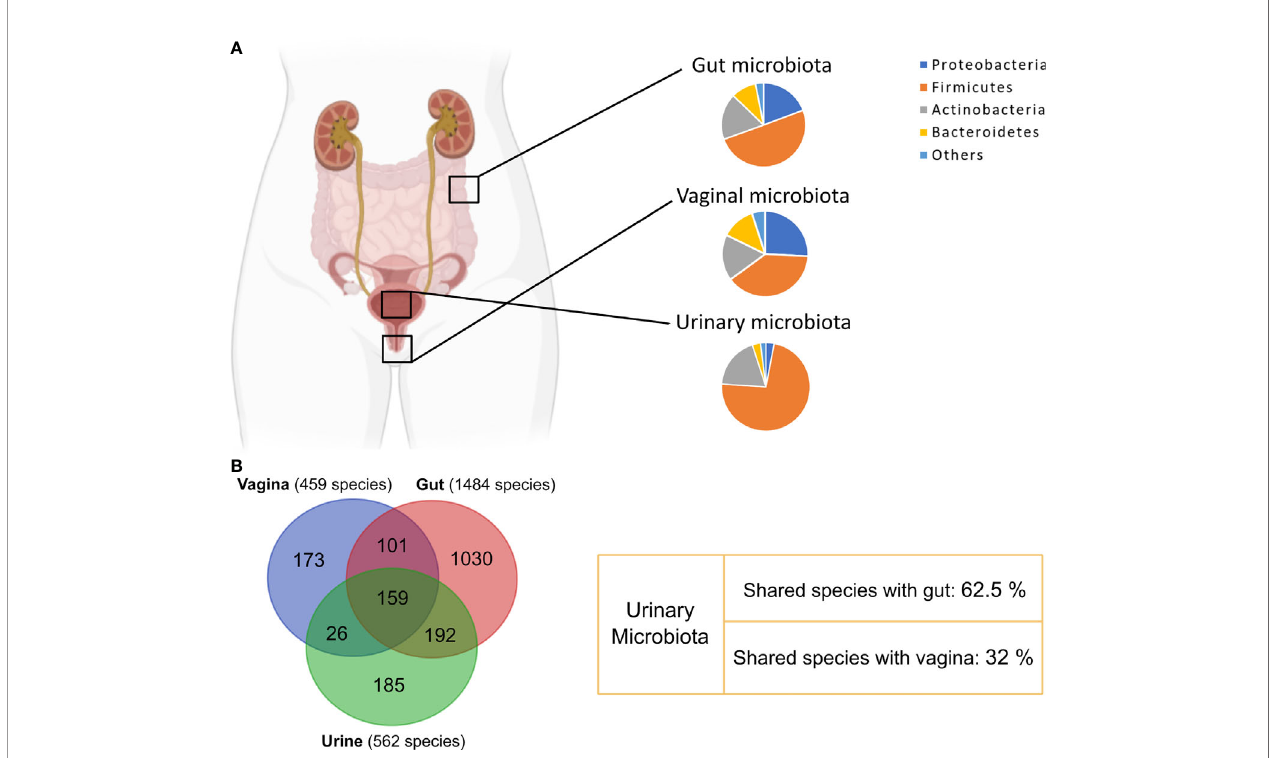
FIGURE 3 | Comparison between urinary, vaginal and gut bacterial communities. (A) Phyla relative abundance in urinary (Modena et al., 2017), vaginal (Diop et al., 2019) and gut microbiota (Morand et al., 2019). (B) Venn diagram showing overlapping species between urinary (Morand et al., 2019), gut (Morand et al., 2019) and vaginal (Diop et al., 2019)